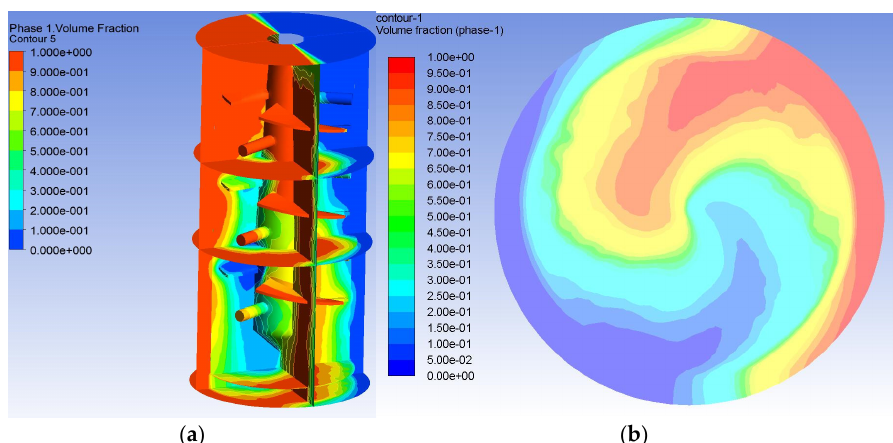
Figure 8. Schematic diagram of material mixing in the stirring chamber ( a ) and exit section phase distribution ( b ). distribution ( b